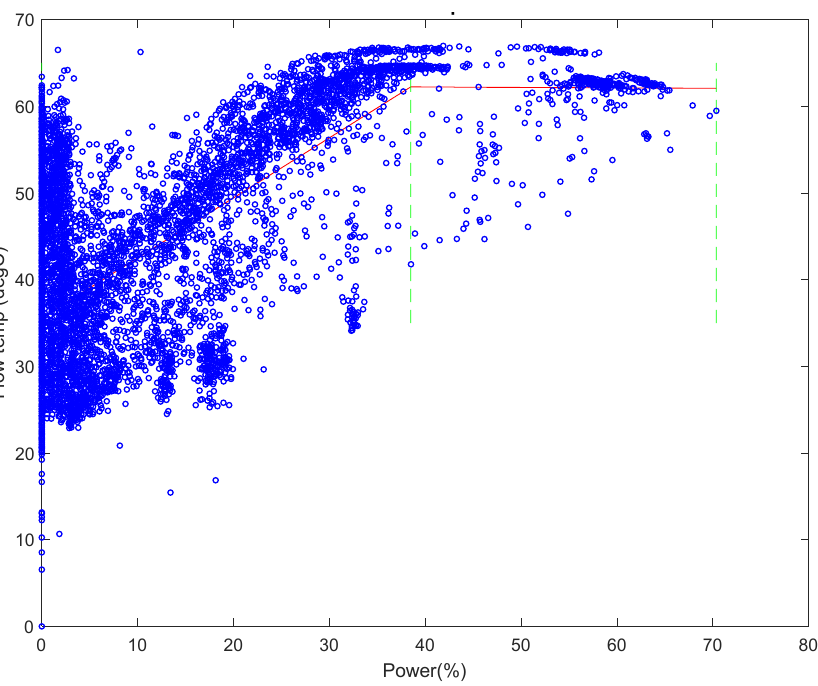
Figure 5. Broken-stick regression of flow temperature against power output, Figure 5. Broken ‐ stick regression of flow temperature against power output, OXF1.